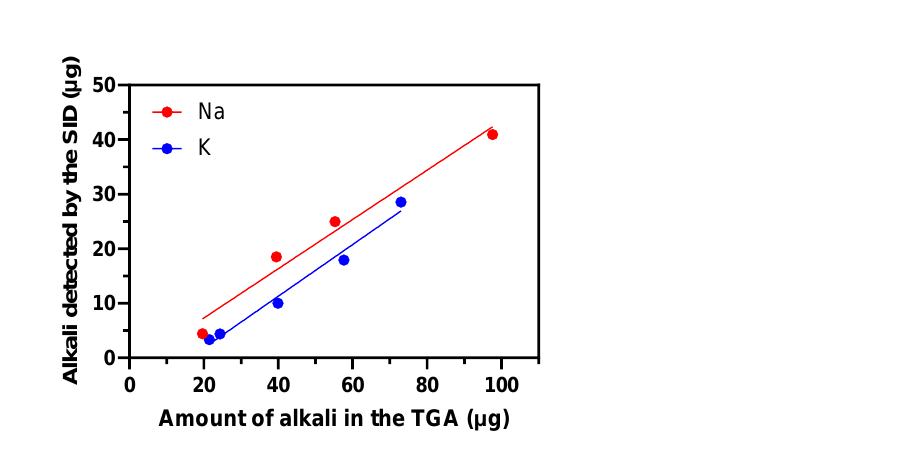
Figure 3. The integrated amount of alkali detected by the SID as a function of the amount of K or Na used in the TGA.